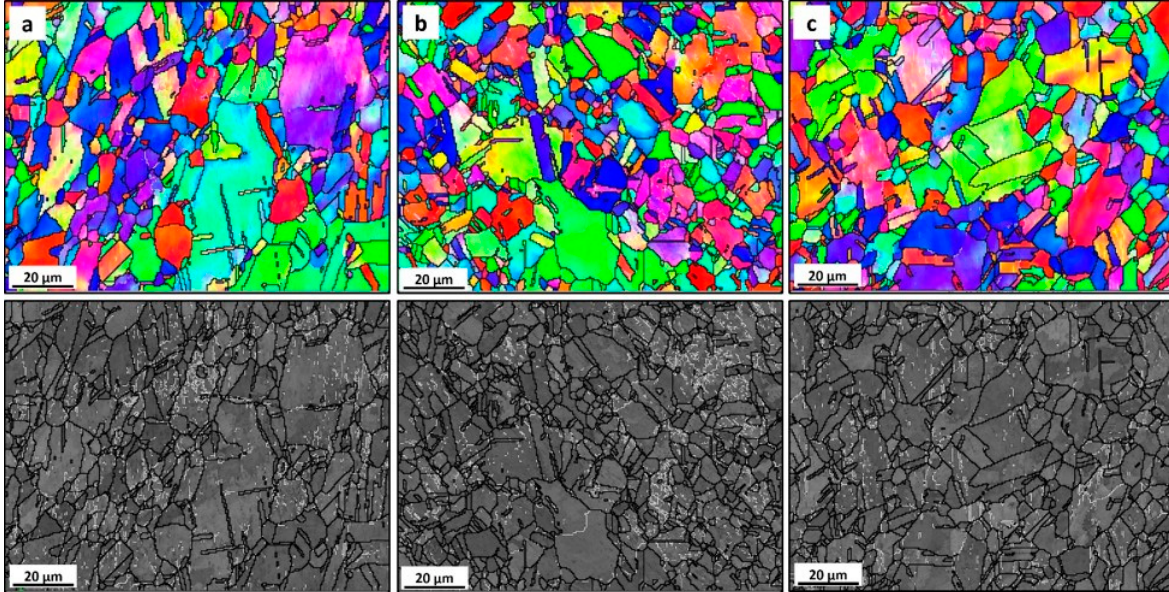
Figure 6. IPF coloring maps relative to normal direction “Z” (ND) and their corresponding band contrast maps with the angle boundaries superimposed for the commercial pure Cu ECAP processed at room temperature (RT) for 1-P. ( a ) Left edge, ( b ) center and ( c ) right edge. Step size used in EBSD data collection was 0.5 µm in all cases (for interpretation of the references to color in this figure legend, the reader is referred to the web version of the article).